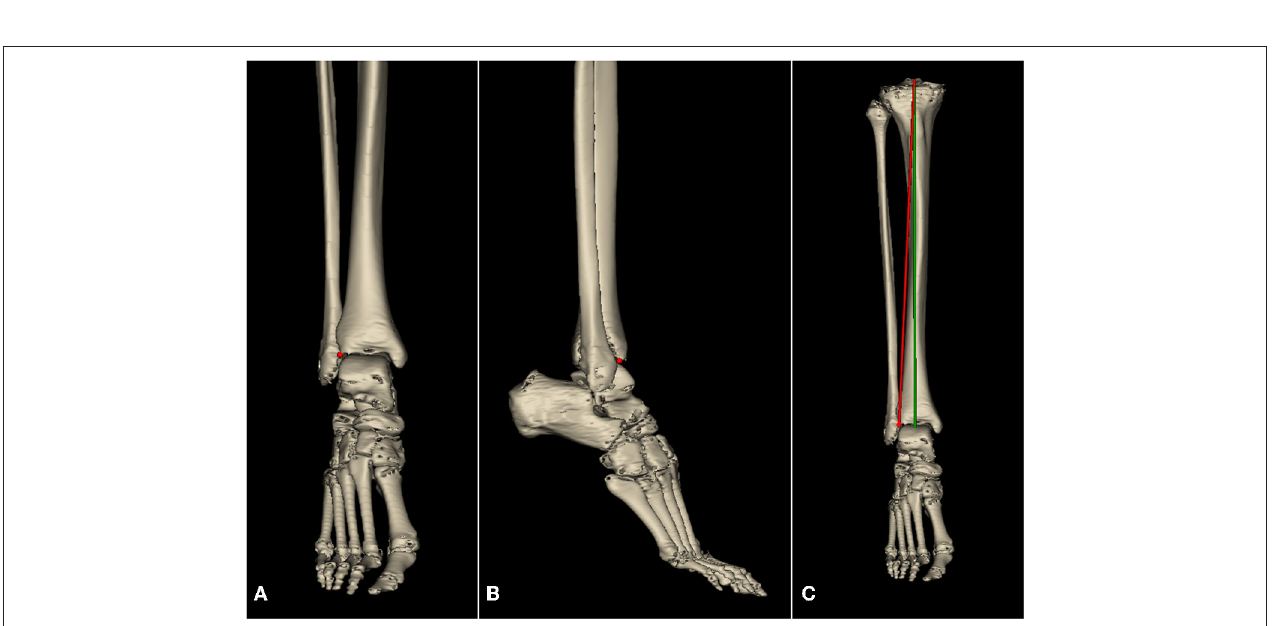
FIGURE 2 | Lateral point of articular surface of distal tibia (LADT, red point) on the tibial reconstruction, and tibial component alignment of AA and MA. (A) Coronal plane. (B) Sagittal plane. (C) Tibial component alignment of AA (red line) and MA (green line).